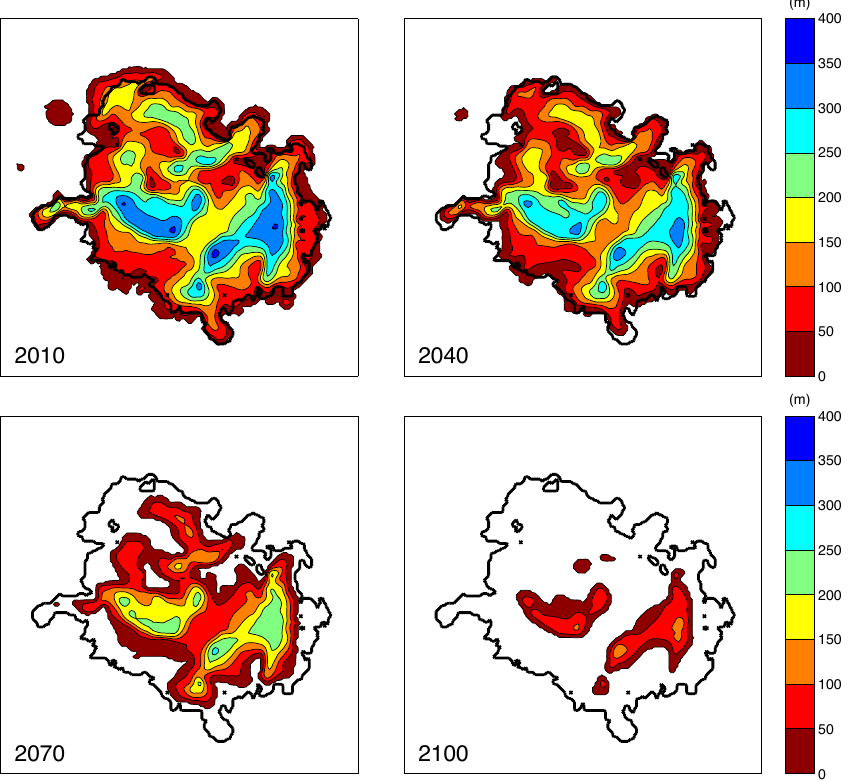
Fig. 13. Modelled ice thickness for 2010, 2040, 2070 and 2100, for the climate projection with 1T =+3 ◦ C and 1P =+10%. Contour lines are drawn every 50m. The thick line indicates the present-day ice cap